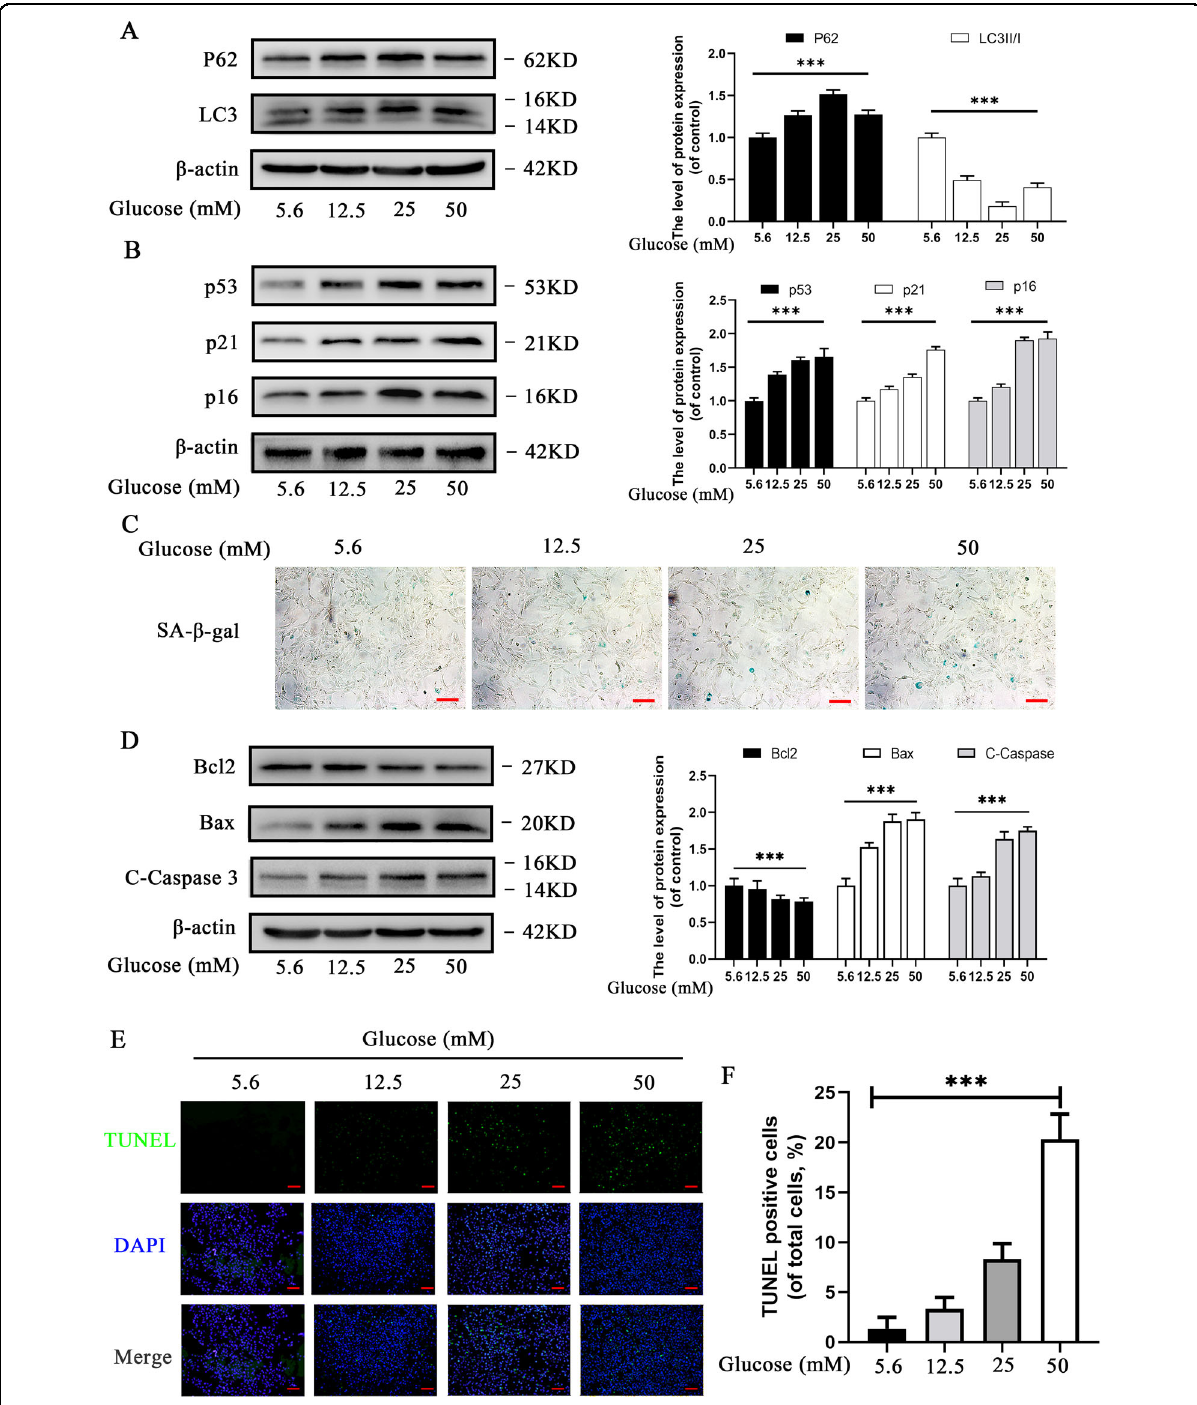
Fig. 1 Effects of high glucose (5.6, 12.5, 25, and 50 mM) on autophagy, apoptosis, and senescence in chondrocytes. A Western blot results and quanti fi cation analyses of p62, and LC3 in chondrocytes under various glucose concentrations. B Western blot results and quanti fi cation analyses of p53, p21, and p16 treated with various glucose concentrations. C Representative micrographs of SA- β -gal staining representing the effects of glucose on senescence. Scale bar 100 μ M. D Western blot results and quanti fi cation analyses of Bcl2, Bax, and cleaved caspase-3 treated with various glucose concentrations. E Representative micrographs of TUNEL staining representing the effects of glucose on apoptosis. F TUNEL-positive cell intensity under various glucose concentrations. Scale bar = 200 μ M. Data are presented as means ± SD ( n = 5). * P < 0.05, ** P < 0.01 , and *** P <